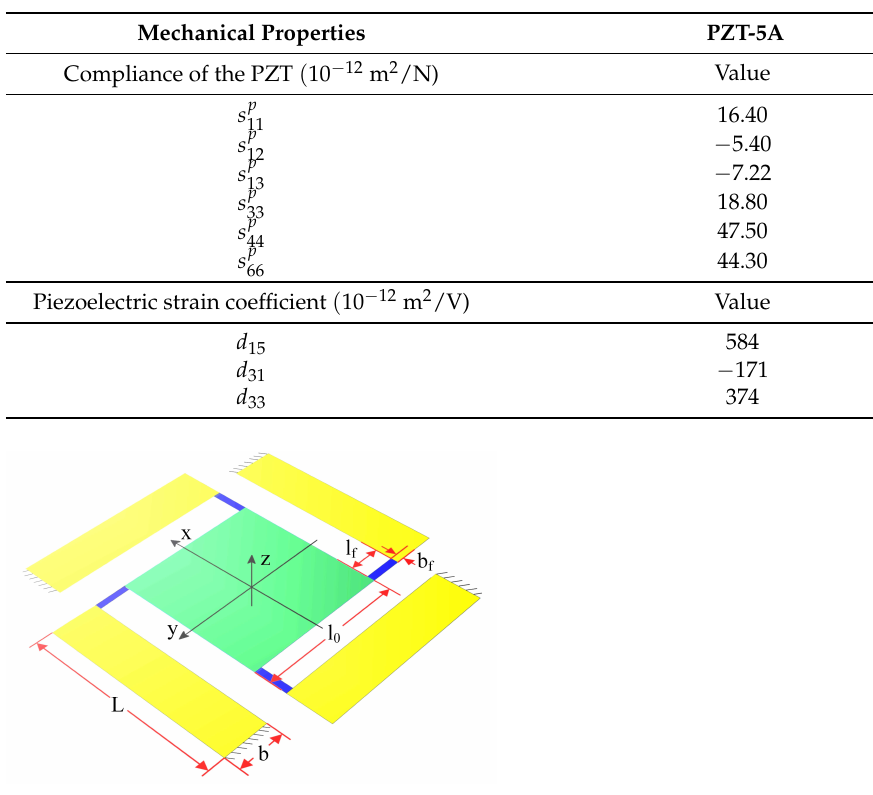
Table 3. Parameters of PZT-5A.